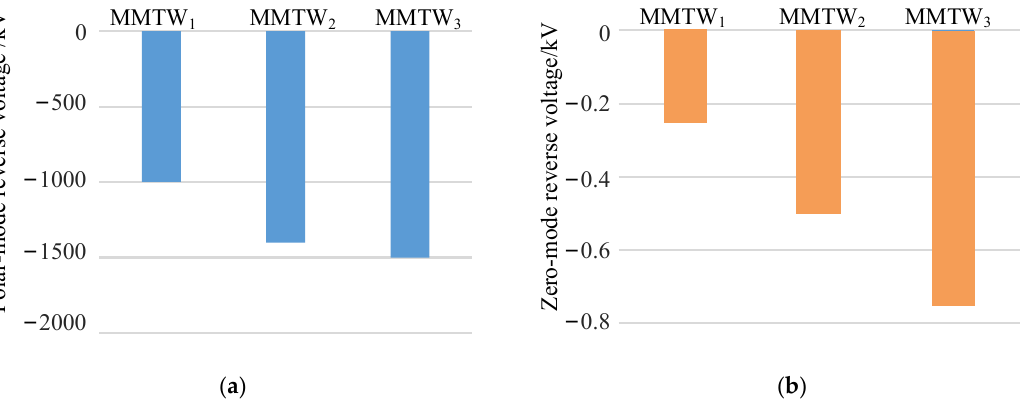
Figure 13. Bipolar metal grounding short-circuit fault result: ( a ) polar-mode and zero-mode voltage waveforms. ( b ) Traveling wave waveforms of polar-mode reverse and zero-mode reverse voltage. The fault features of a polar-mode reverse-voltage traveling wave and zero-mode reverse-voltage traveling wave of the DC line are extracted, and the wavelet modulus maxima at each scale are calculated. According to Figure 14, there is only one extreme value of the polar-mode reverse-voltage traveling wavelet mode extreme value at each scale. It increases at scale, so the fault can be judged as an internal fault in the region. The zero-mode reverse-voltage wavelet mode maximum value is near zero at each scale, and there is no obvious maximum value, so the fault is judged to be a bipolar fault.